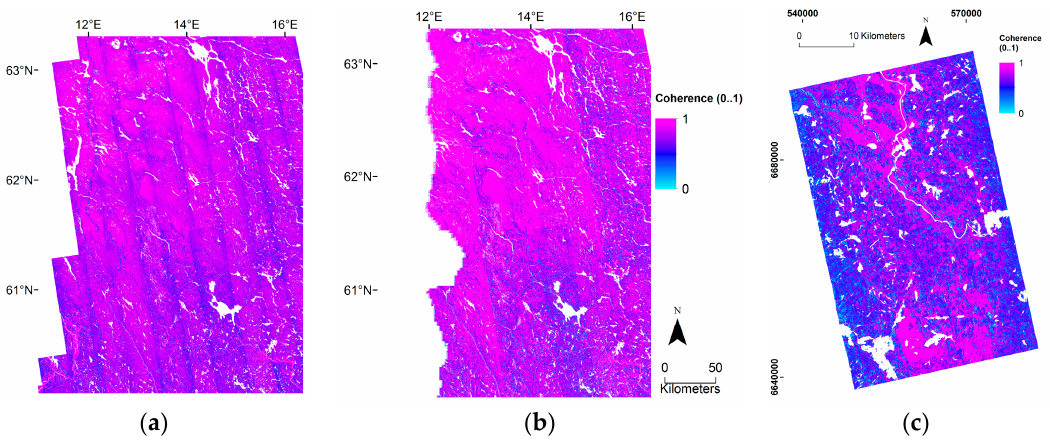
Figure 5. Illustration of the differences in coherence between different satellite orbits and within single scenes before ( a ) and after ( b ) correction. An enlarged example of the range-wise attenuation within a single scene is demonstrated in ( c ).